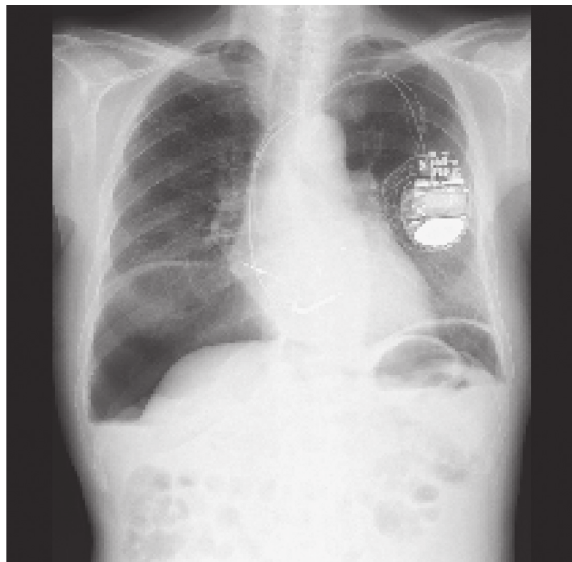
Figure 1: Chest X-ray upon admission. Bilateral free air in the abdomen was observed.